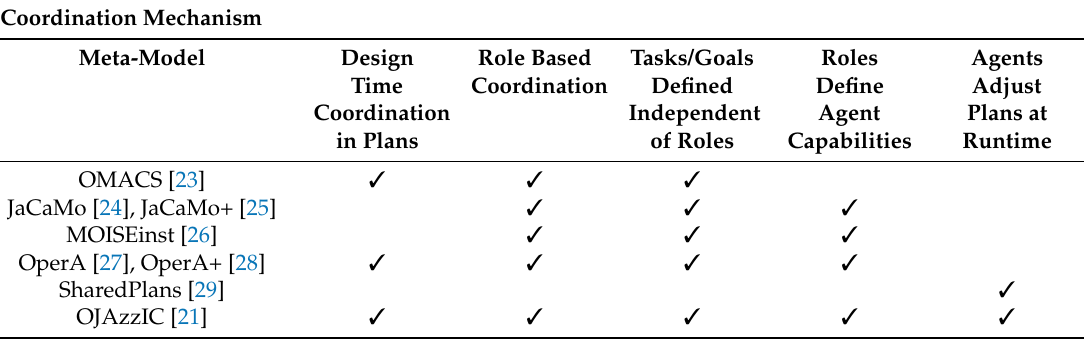
Table 1. Comparing meta-models in relation to coordination.